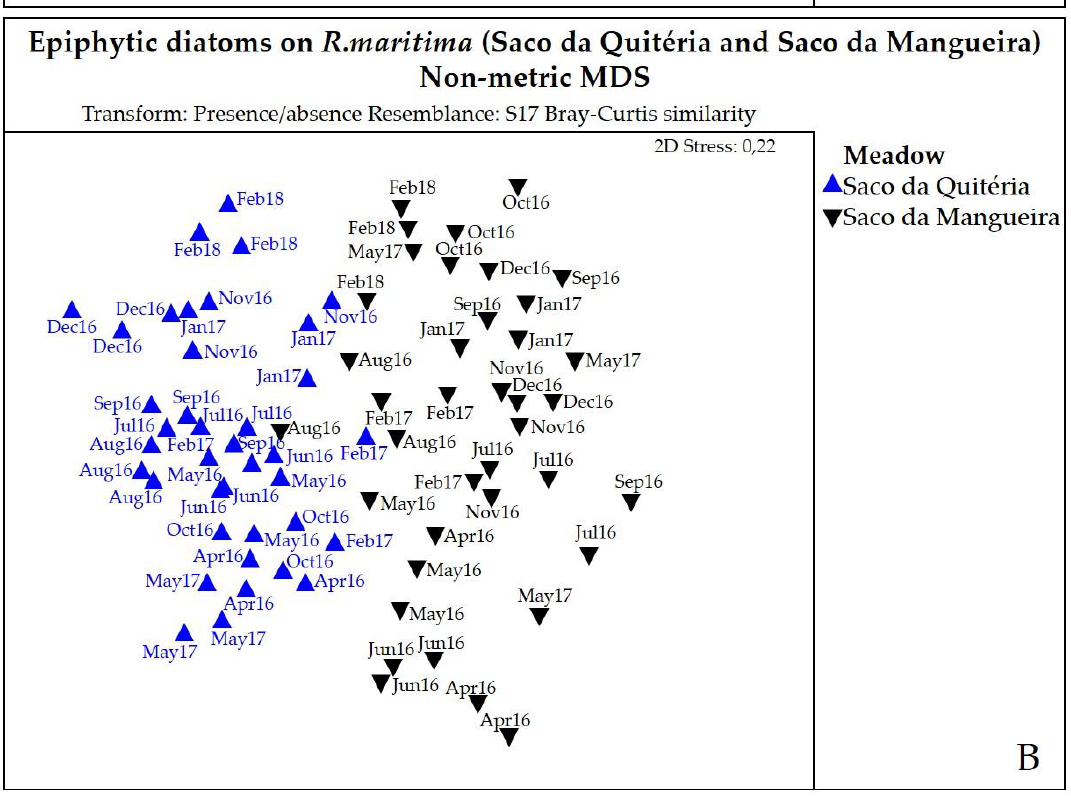
Figure 7. Results of non-metric multidimensional scaling (NMDS) analysis of samples from both sites during the study period. ( A ) abundance and ( B ) composition (presence and absence). Matrix composed of 80 sp. in both analyses. Q = Saco da Quitéria; M = Saco da Mangueira.